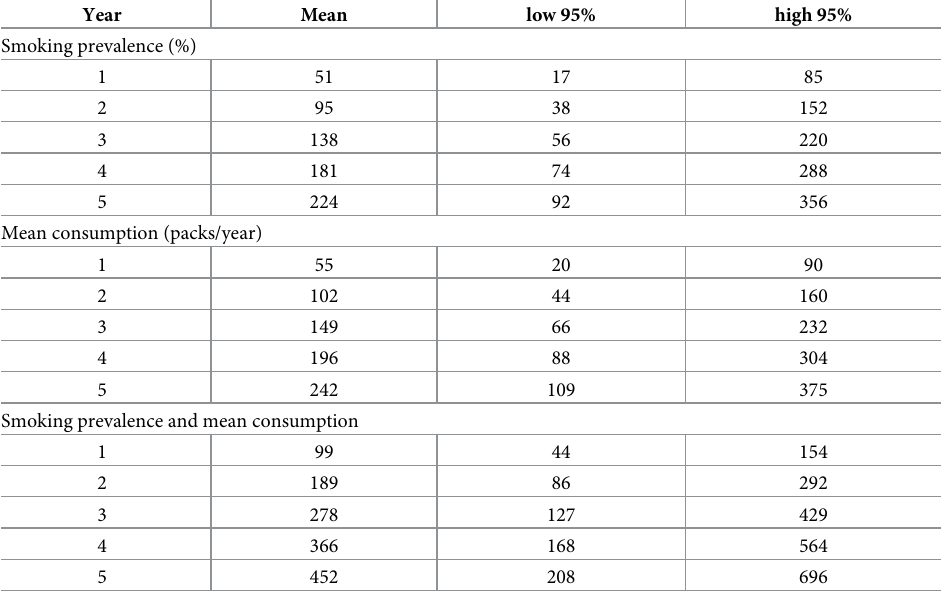
Table 3. Effect of an annual 5% relative reduction in measures of smoking behavior beginning in 2014 per year for five years: 2015 (year 1) to 2019 (year 5)